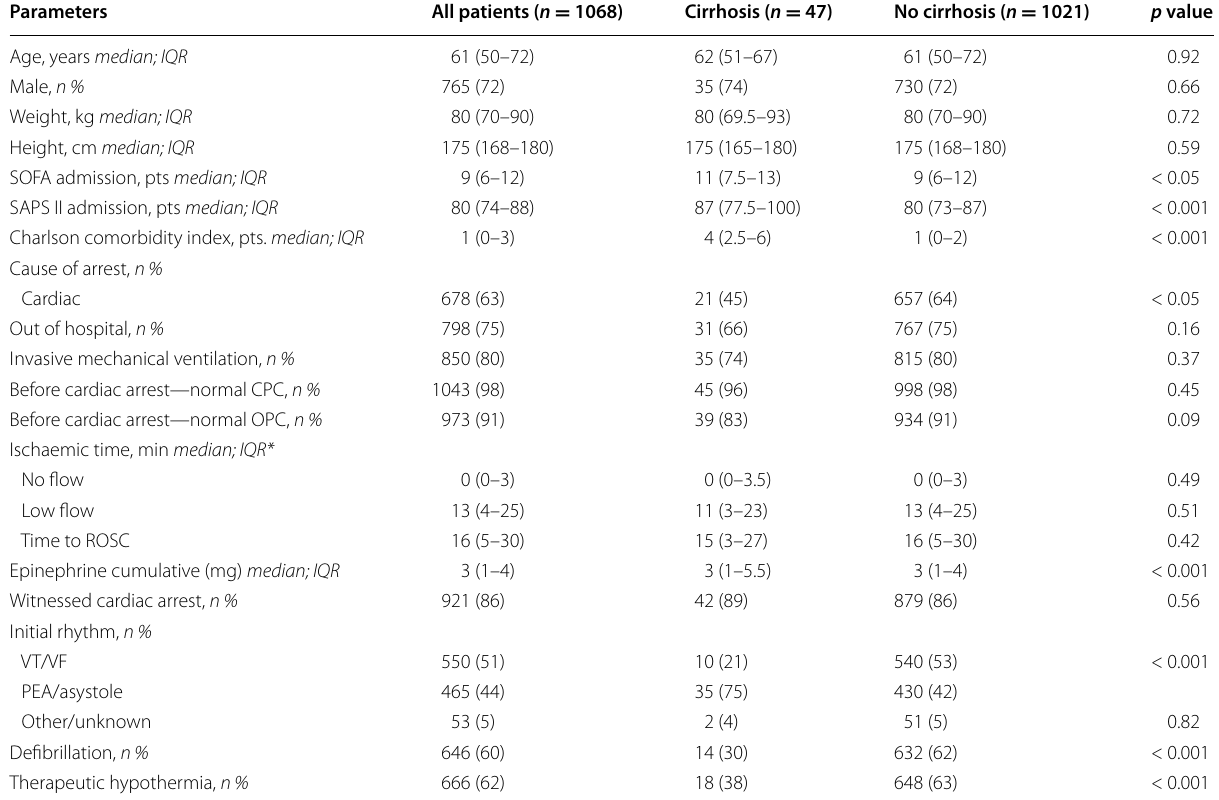
Table 1 Patients’ characteristics of the study population at admission stratified according to the presence of